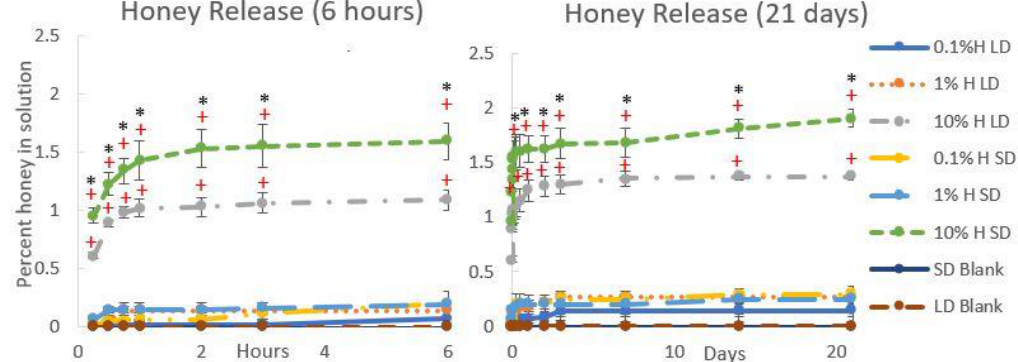
Figure 3. Honey release is higher for SD templates than LD templates. Percent honey v / v in PBS incubated with each template type for 21 days. * indicates a significant di ff erence between the LD and SD templates of the corresponding honey concentration, and + indicates a significant di ff erence from all other honey concentrations and non-honey blank of the corresponding fiber diameter (SD or LD). Note: the 1% honey LD samples are significantly di ff erent from the LD blank from day 3 onward, the 1% honey SD samples are significantly di ff erent from SD blank for days 14 and 21, and the 0.1% honey SD samples are significantly di ff erent from SD blank from day 3 onward. Due to clustering of these lines on the graphs, these di ff erences were unable to be notated. Sample size = 4. Raw data is available in Supplementary Spreadsheet